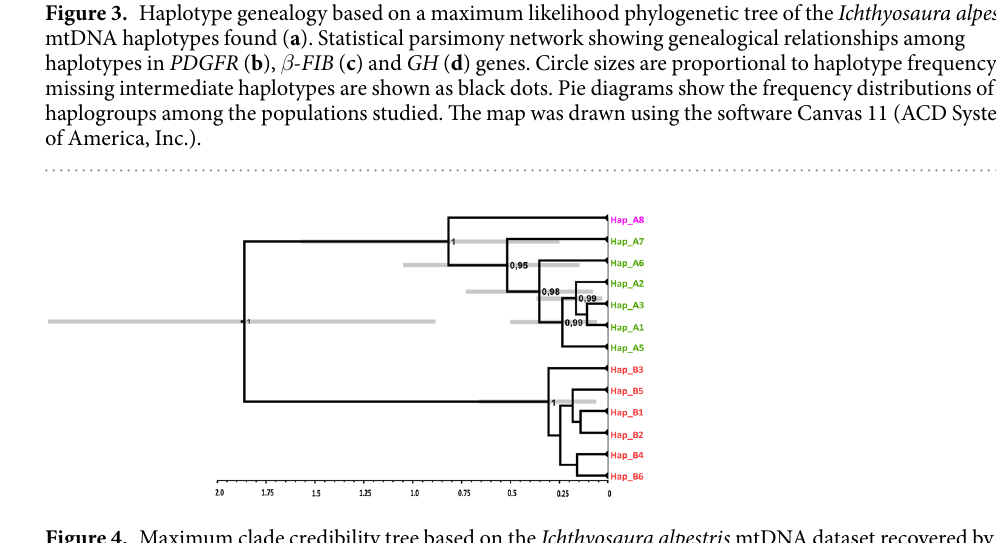
Figure 4. Maximum clade credibility tree based on the Ichthyosaura alpestris mtDNA dataset recovered by Bayesian analysis in BEAST, showing the time to the most recent common ancestor (TMRCA) for the major clades. Node bars (grey) represent 95% highest posterior density (HPD) intervals for node ages. The posterior probabilities for each node are also shown (only values > 0.9 are shown). The scale is in millions of years before present. The graph was drawn using the software Canvas 11 (ACD Systems of America,